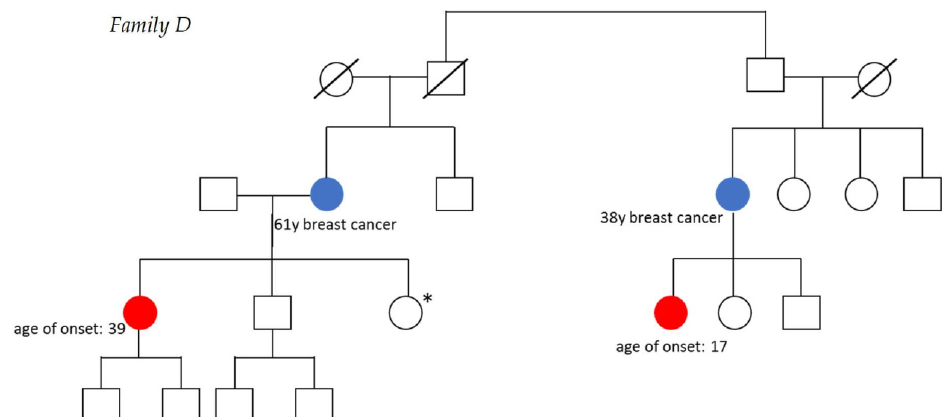
Figure 1. Family pedigrees. Colors represent diagnosis of AGCT, other cancer or cardiovascular disease. Deceased persons are indicated with a slash (/). Family A. Patients were related via their grandfathers. Family B. The AGCT patients represented mother and daughter. Family C. The AGCT patients represented niece and aunt. Their mother, respectively sister was diagnosed with breast cancer. Patient C2 was involuntarily childless because of subfertility and more cases of subfertility were reported in this family. Family D. The AGCT patients were related through their grandfathers, who were brothers. Both mothers of the patients were diagnosed with breast cancer. One of the patient’s sisters was also involuntarily childless due to subfertility.